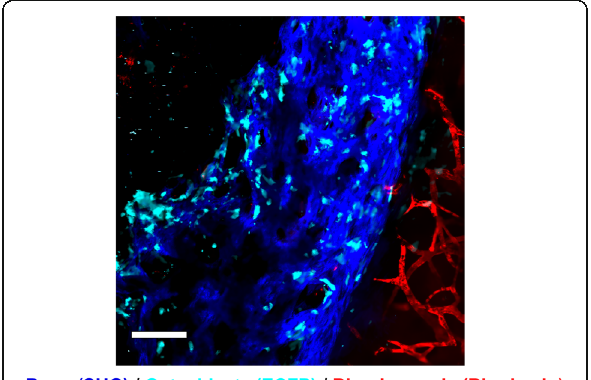
Fig. 2 Representative intravital two-photon microscopy images of ectopic bone formation area in Col2.3-ECFP mice (visualization of blood vessels). Visualization of osteoblasts, newly formed bone (collagen), and blood vessels after implantation of a collagen sponge containing BMP-2 [15]. Cyan, osteoblasts expressing Col2.3- ECFP; red, blood vessels stained with rhodamine; blue, collagen fibers (second harmonic generation, SHG). Scale bar, 100 μ m